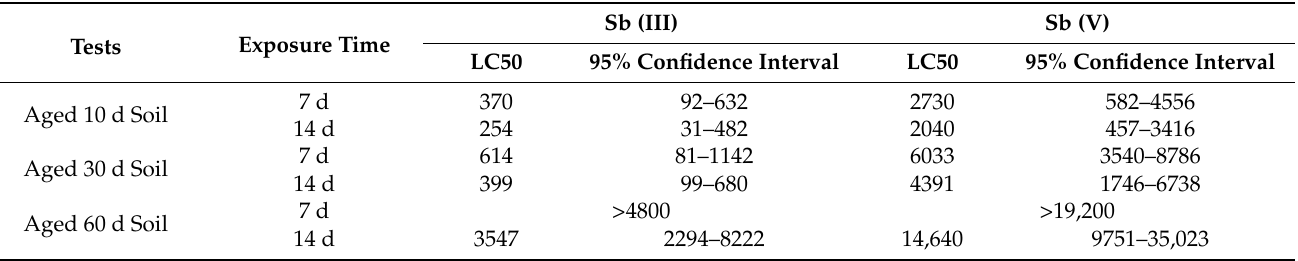
Table 3. LC50 (mg/kg dry weight, 95% confidence intervals) of Sb (III) and Sb (V) to E. fetida in chronic soil toxic assay.